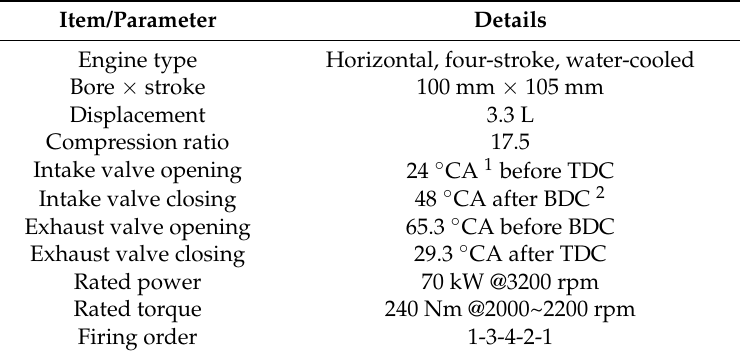
Table 1. Main technical specifications of diesel